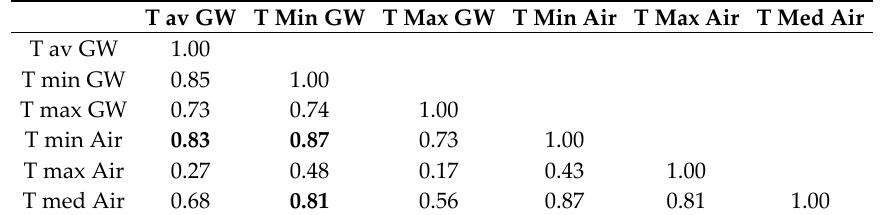
Table 3. Correlation matrix with Pearson coefficients for the selected variables. Numbers in bold are representative